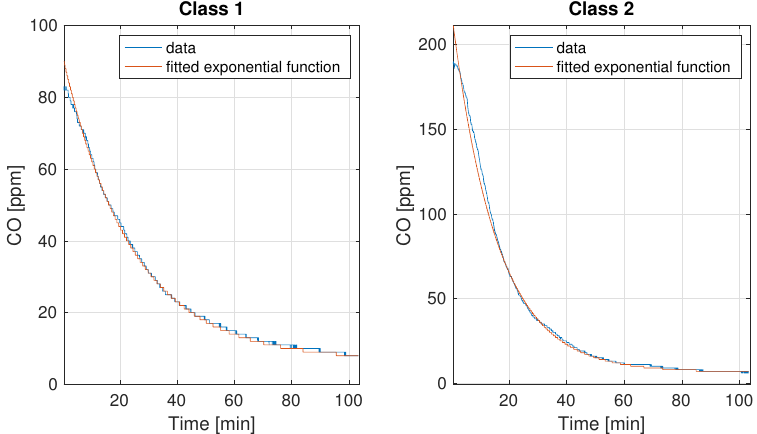
Figure 15. The examples of the exponential function fitting (11)—the process after